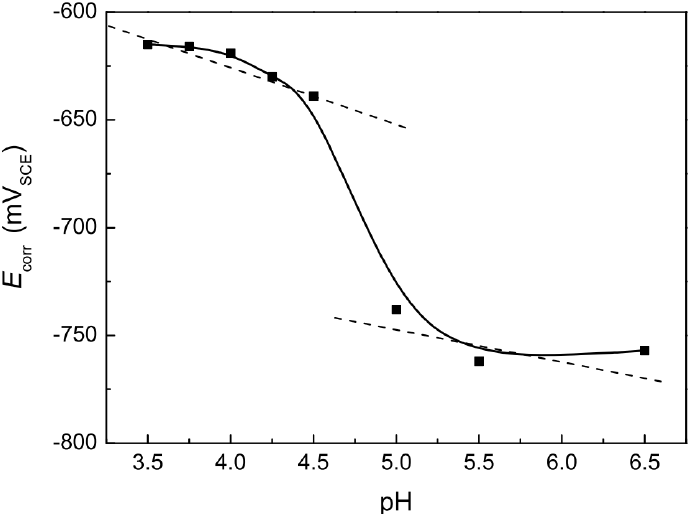
Figure 14. Variations of open circuit potential of the X70 samples in the different pH acidic soil solutions [69]. Reprinted with permission from [69], 2013, Springer nature